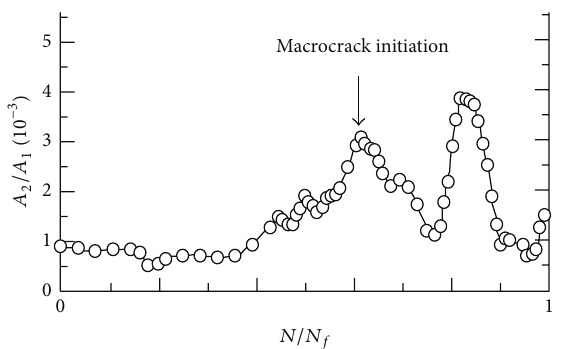
Figure 2: Typical evolution of the ratio 𝐴 2 (𝑓 𝑟 /2)/𝐴 1 (𝑓 𝑟 ) for 0.25 mass% C steel, 𝑁 𝑓 = 56, 000